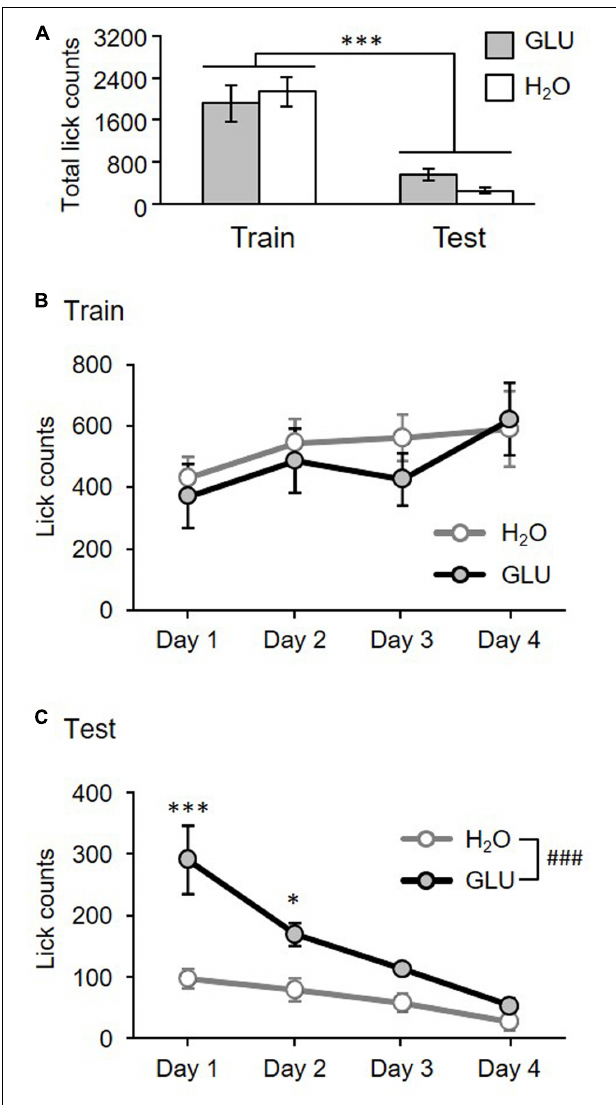
FIGURE 2 | Total number of licks for 4 days (A) and lick-tendency across 4 days (B,C) in the training and test sessions for GLU and H 2 O groups. (A) Total number of licks for 4 days. The histograms show the total lick counts for 4 days in H 2 O (white bars) and GLU group (gray bars), in Training (Train) and Test (Test) sessions. There was a significant main effect of task condition (Training vs. Test). ∗∗∗ p = 4.5 × 10 − 6 . (B,C) Lick-tendency in training (B) and test (C) . Ordinates indicate averaged daily in each experimental day. (B) No significant differences have been found. (C) There were significant main effects of group, and day, and significant interaction between group and day. ### p = 0.0017; ∗∗∗ p = 8.0 × 10 − 7 ; ∗ p = 0.011. Error bars represent ± SEM.